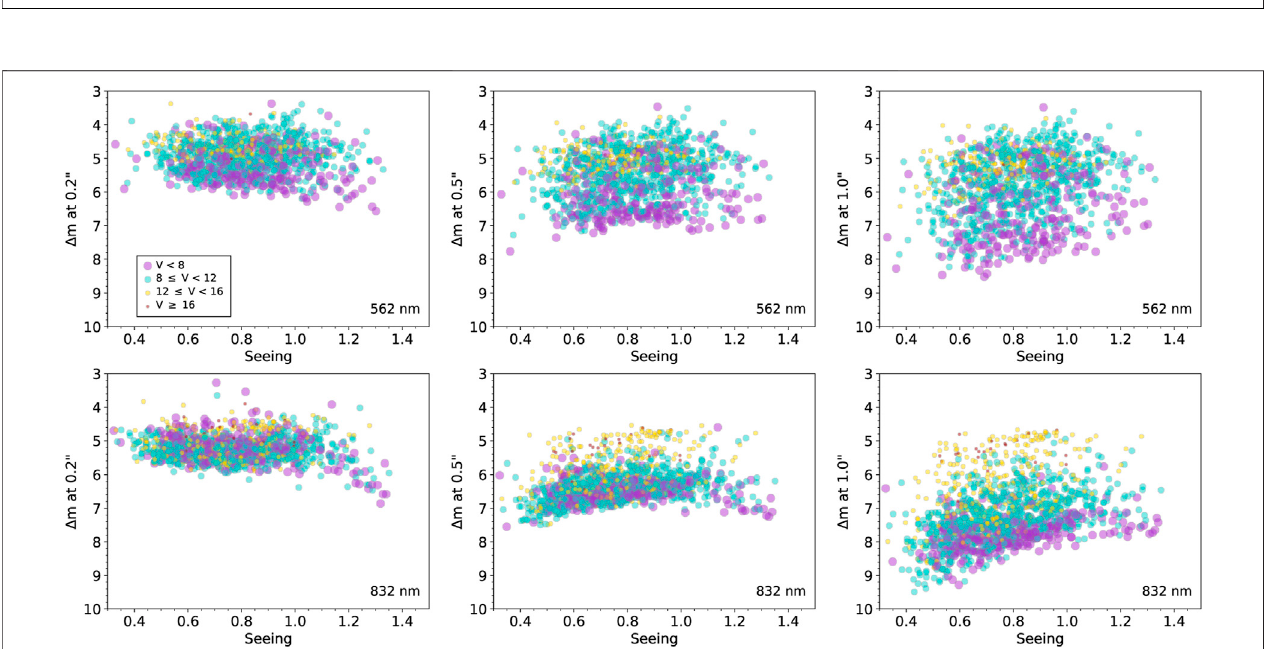
FIGURE 3 | Results from ‘ Alopeke observations in terms of how seeing (given in arcseconds) effects the contrast level achieved for a given target magnitude. The leftpanelsshowthelimitingcontrastvaluesat0.2 ″ fromthetargetstar,themiddlepanelthecontrastat0.5 ″ ,andtherightpanelthecontrastat1.0 ″ .Thetopandbottom rows show the results for 562 nm data and 832 nm observations, respectively. The bins of target magnitude are color-coded and vary with symbol size as shown in the legend.